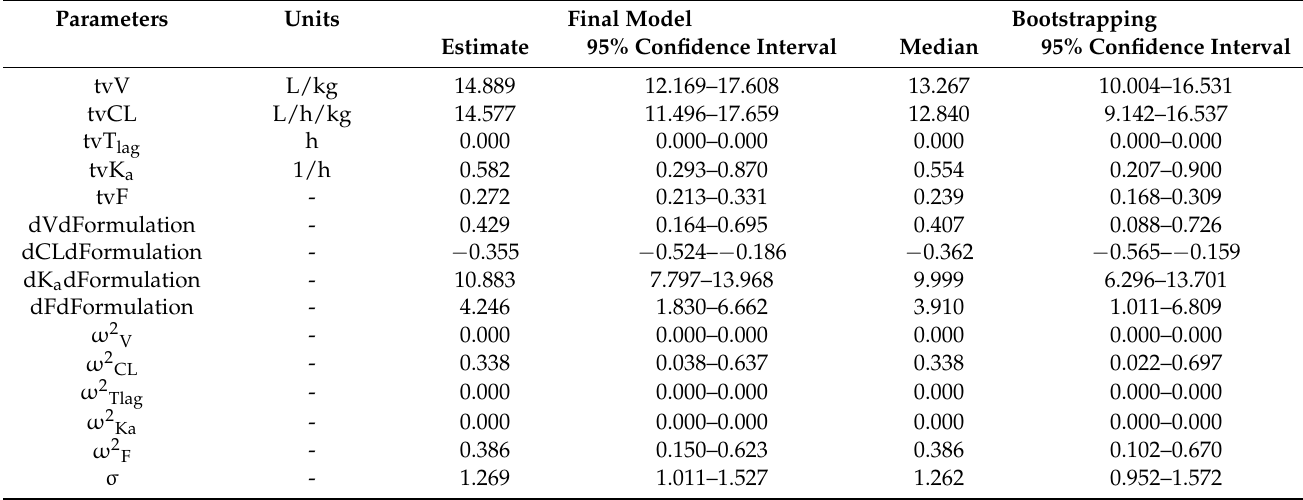
Table 4. Estimated population pharmacokinetic parameter values of free methotrexate solution and methotrexate-loaded nanoformulations, and bootstrap validation ( n =